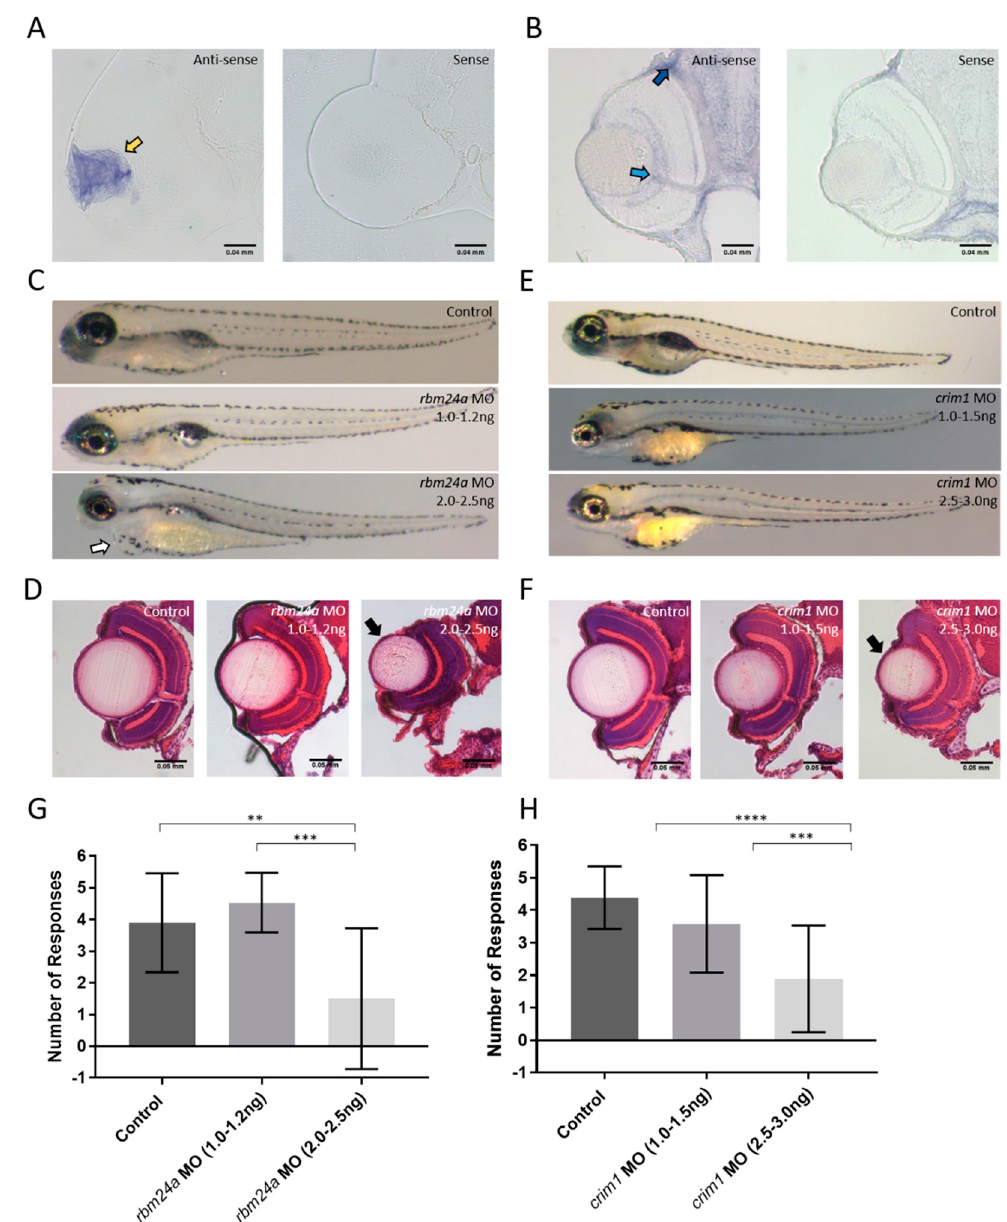
Figure 4. Analysis of candidate genes. Whole mount in situ hybridization on 3 dpf retinal sections for ( A ) rbm24a ; ( B ) and crim1 ; ( C ) Phenotypes of control, rbm24a AUG MO at 1.0–1.2 ng, and rbm24a AUG MO at 2.0–2.5 ng; ( D ) H and E staining of control, rbm24a AUG MO at 1.0–1.2 ng, and rbm24a AUG MO at 2.0–2.5 ng; ( E ) Phenotypes of control, crim1 AUG MO at 1.0–1.5 ng, and crim1 AUG MO at 2.5–3.0 ng; Same magnification as ( A ); ( F ) H and E staining of control, crim1 AUG MO at 1.0–1.5 ng, and crim1 AUG MO at 2.5–3.0 ng. Same magnification as ( B ); ( G ) VIZN analysis of control ( n = 19), rbm24a AUG MO at 1.0–1.2 ng ( n = 18), and rbm24a AUG MO at 2.0–2.5 ng ( n = 10) (Mann–Whitney p -value ** = 0.0068, *** = 0.0003); ( H ) VIZN analysis of control ( n = 39), crim1 AUG MO at 1.0–1.5 ng ( n = 31), and crim1 AUG MO at 2.5–3.0 ng ( n = 18) (Mann–Whitney p -value **** < 0.0001). Yellow arrow indicates lens staining. Light blue arrow denotes ganglion cell layer staining. Dark blue arrow indicates choroid staining. Black arrows point to microphthalmic eyes. White arrow indicates cardiac edema. Scale bars in ( A ) and ( B ): 0.04 mm, and in ( D ) and ( F ): 0.05 mm.